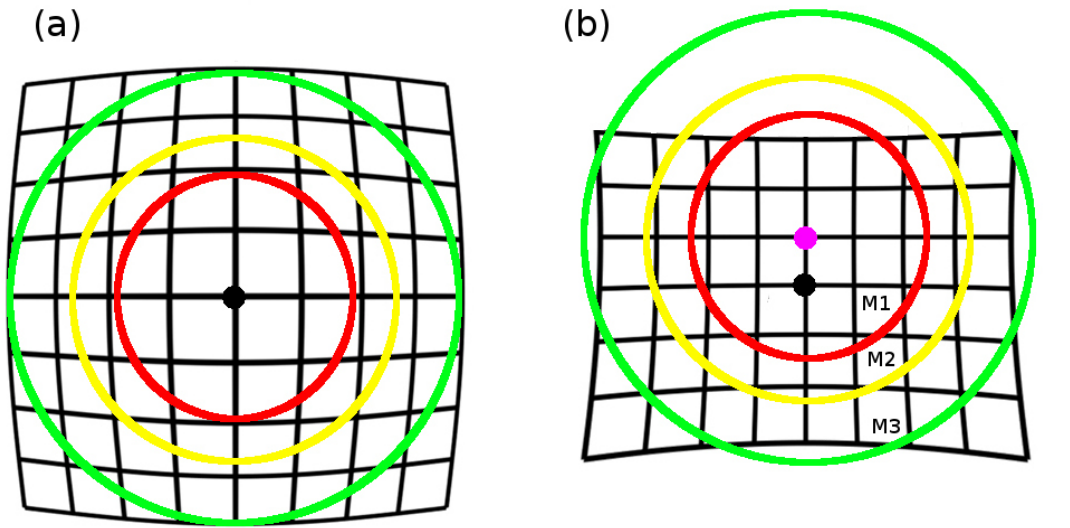
Figure 2. Illustrations of radial symmetry; see Equation (5). ( a ) Barrel distortion, η < 0; ( b ) pincushion distortion with a (magenta) center of distortion different from the (black) center of the image. Symmetry is employed while solving the fundamental matrices F k and the radial correction parameter of Equation (9) consecutively. Here, each iteration increases the amount of inliers, M 1 < M 2 < M 3 < ..., until the convergence of Equation (11) is reached, and η > 0 is